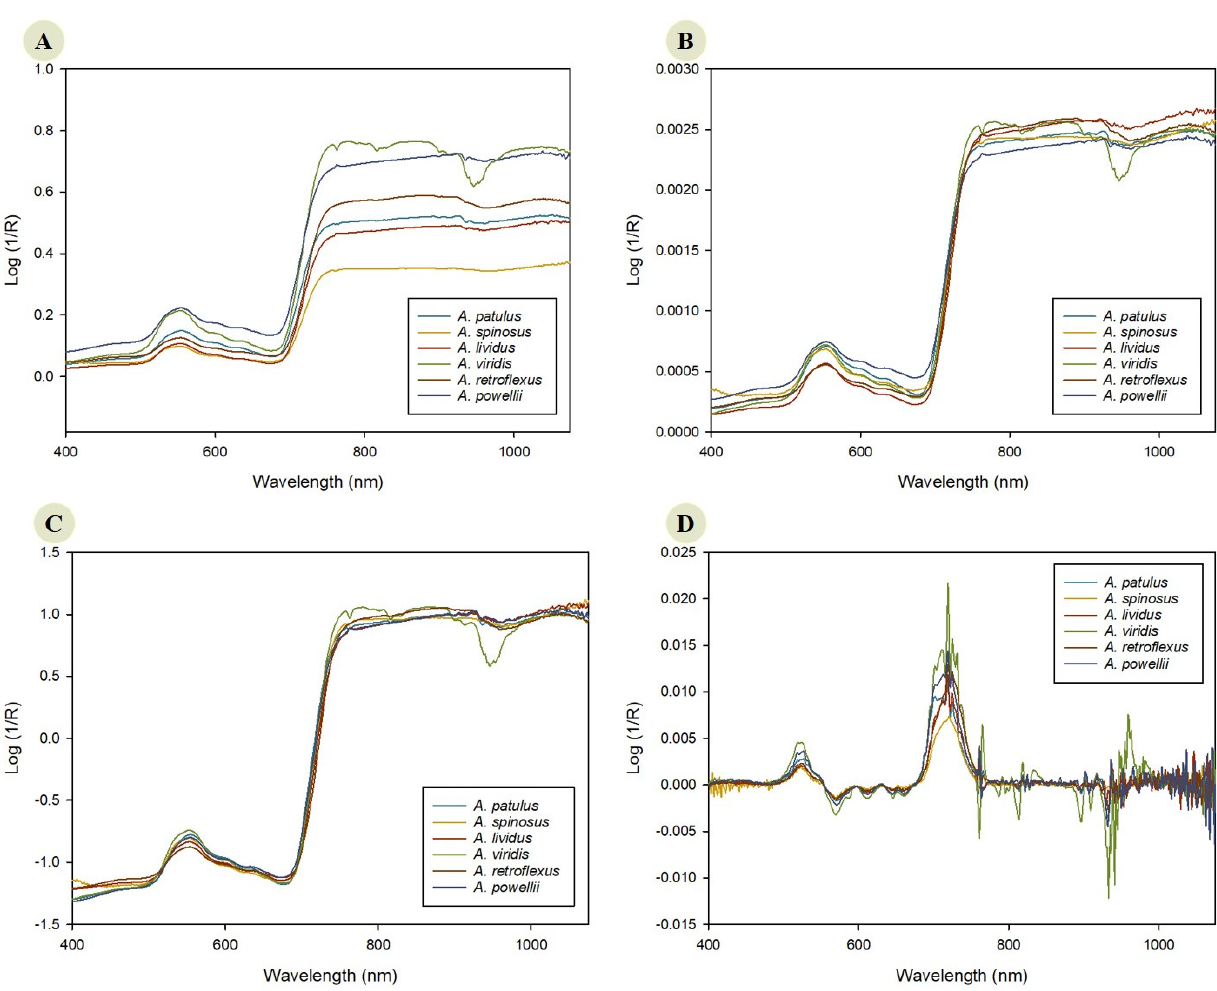
Figure 4. Average raw and preprocessed spectra of six Amaranthus sp. Average spectra of raw ( A ), preprocessed with different methods such as normalization ( B ), SNV ( C ), Savitzky-Golay ( D ) methods.